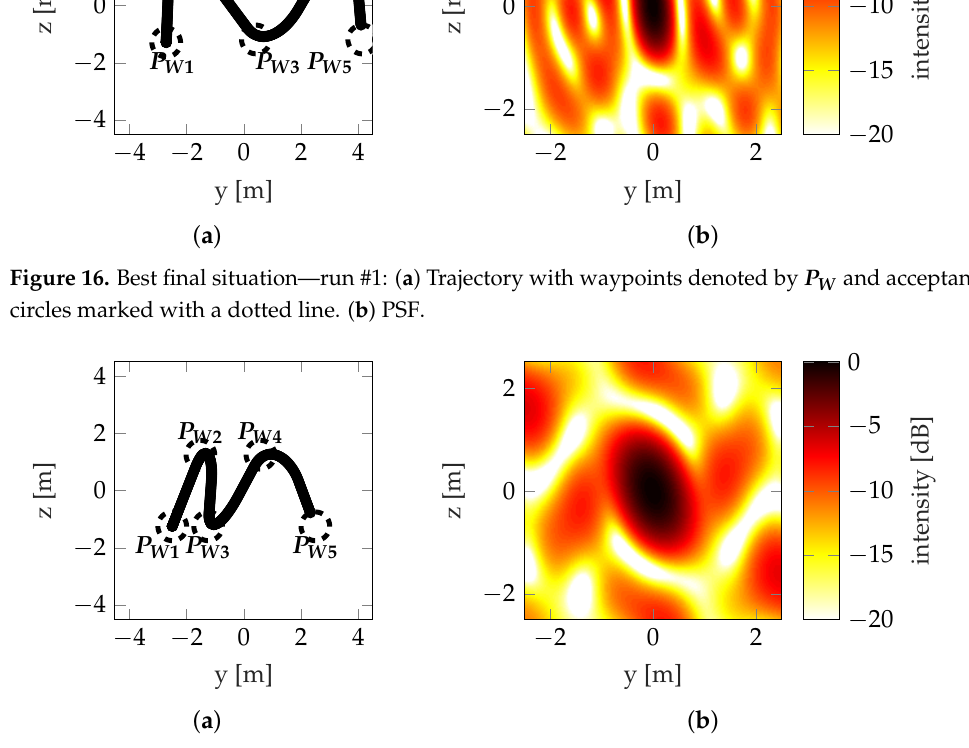
Figure 17. Initial state for the worst final situation—run #8: ( a ) Trajectory with waypoints denoted by P W and acceptance circles marked with a dotted line. ( b )